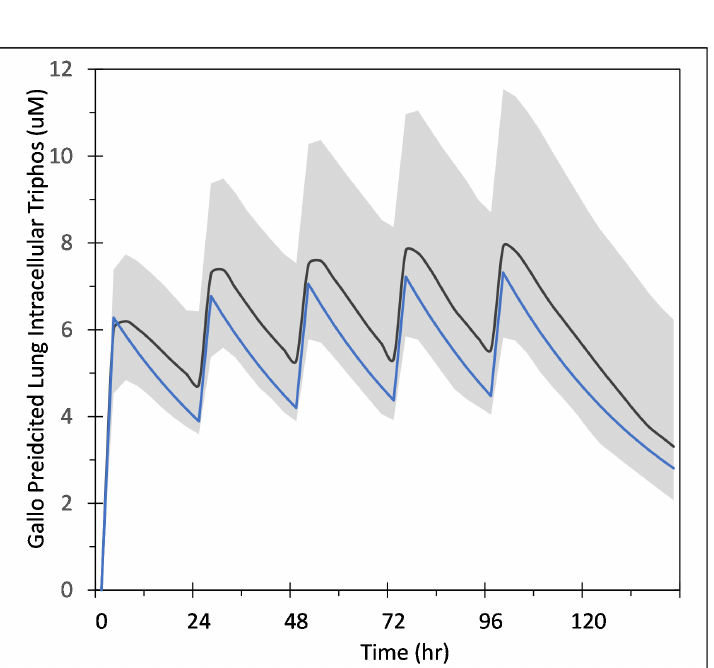
Figure A1. Comparison of our simplified model to Gallo’s population simulation plot of predicted intracellular lung GS-443902 concentration. Gallo’s mean response is shown by the black line and the 95% interval is shaded. This data is from 5000 simulations in which the two key parameters in the Gallo model were sampled from distributions with 20% CV. See Gallo and their supplement Figure S5 for more information. Blue line is our simplified model’s output. The Gallo data used in this plot was digitized from the publication using https://automeris.io/WebPlotDigitizer/ (accessed on 3 November